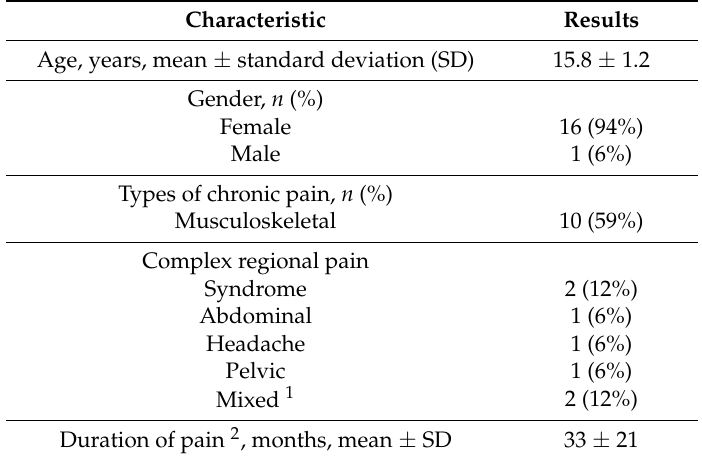
Table 1. Demographic characteristics of the adolescent sample attending the focus group ( n = 17).